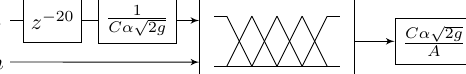
Figure 20. Fuzzy sets tank; ( a ) input set q i , ( b ) input set h , ( c ) output set ˙ h centre of gravity and ( d ) output surface between ˙ h , h and q i . Using the input and output scaling factors, the delay time was added in Figure 21.